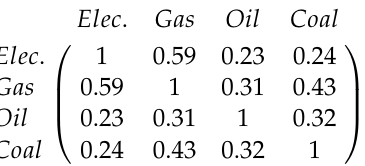
Figure 1. Rolling mean of the volatility and correlation analysis of the commodity prices. These parameters are not constant over time, highlighting the non-stationarity of the market and the difficulty of the calibration. For the sake of simplicity, an average approx- imation is done on these estimates for the calibration of the GBM (the deep generative methods are not concerned). The considered volatilities are ˆ σ Elec . = 44%, ˆ σ Gas = 50%, ˆ σ Oil = 38% and ˆ σ Coal = 25%, and the correlation coefficients